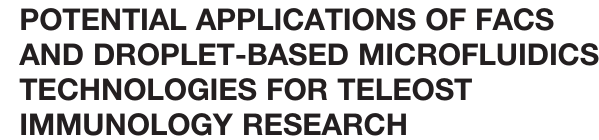
FIGURE 2 | The generation and manipulations of droplets. One of popular methods to generate droplets in micro fl uidics is fl ow-focusing, in which the injected aqueous stream (water phase) is sheared by perpendicular oil streams pumped from two side channels. Once fl uids meet, water in oil droplets are formed and those droplets can be further manipulated: merge of two droplets with different contents, on/off-chip incubation of droplets to allow reactions to occur, detection of fl uorescent signals and sorting of droplets of interest via electric fi